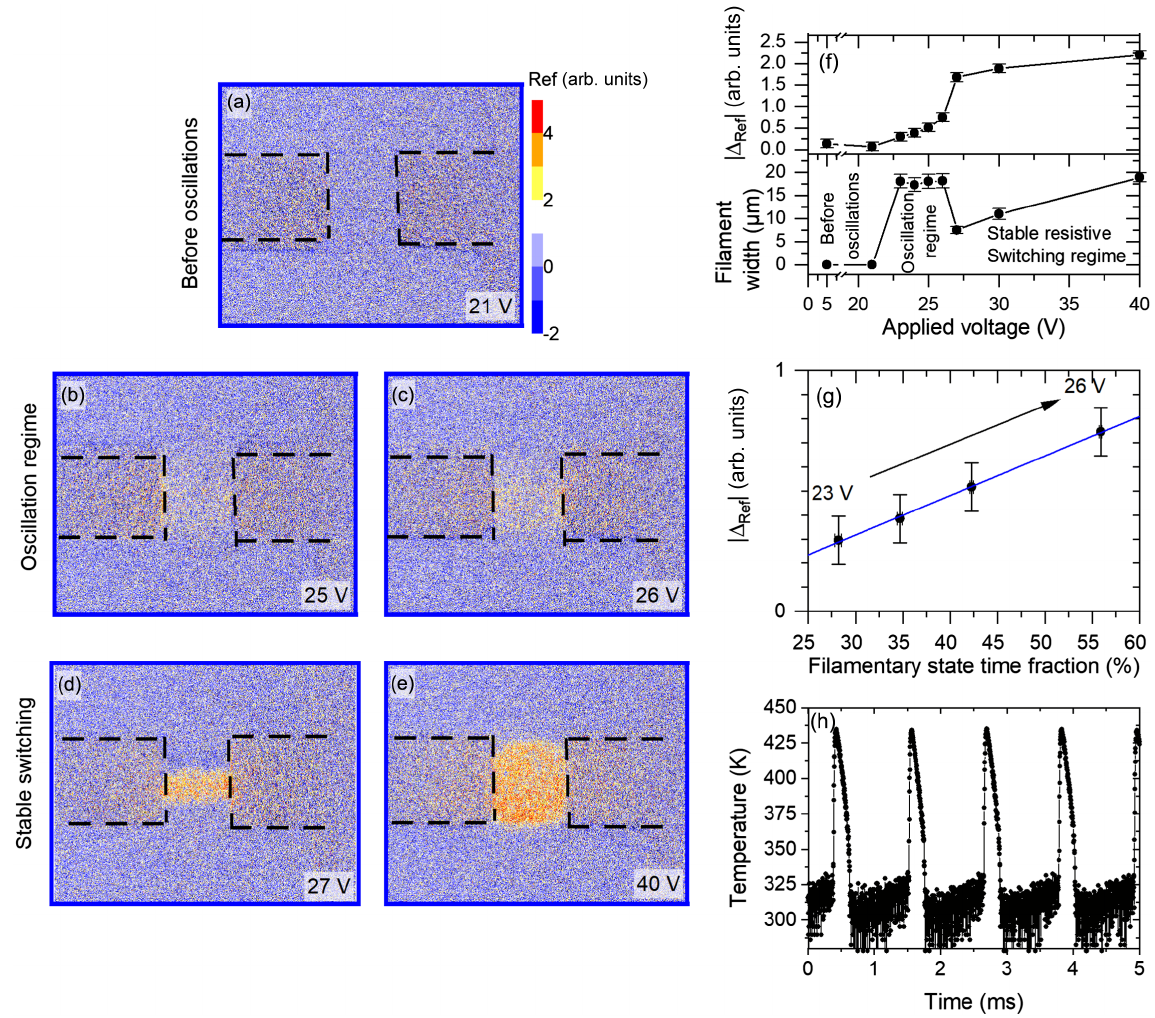
FIG. 4. Optical imaging of the self-oscillation regime in V 3 O 5 . (a) – (e) Differential contrast images of the resistive switching in V 3 O 5 acquired at different voltages, corresponding to the homogeneous regime before oscillations in (a), the oscillation regime in (b) and (c), and during the stable resistive switching regime after the oscillations in (d) and (e). The low-temperature phase is in blue, and the high- temperature phase is in orange. The appearance of a wide low-intensity filament can be seen in the oscillation regime. (f) Applied voltage dependence of the maximum intensity and width of the filament. (g) Intensity of the reflectivity change vs time fraction spent in the filamentary state during the oscillation regime. The time spent in the filamentary state is extracted from the electrical measurement for each voltage (see Supplemental Material [46] for details). (h) Temperature vs time extracted from time-resolved IR measurements in the self-oscillation regime The temperature changes between 325 and 430 K each oscillation